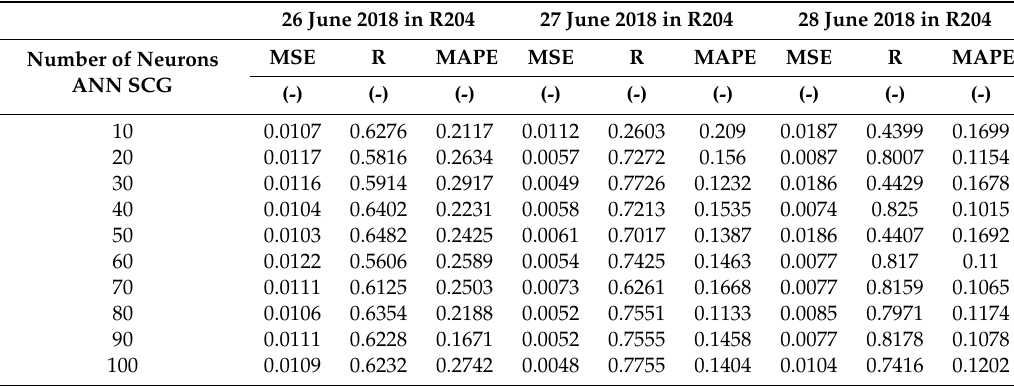
Table 3. Learned ANN SCG from 25 June 2018 in R203 (with T in and rH in ) and prediction with cross-validation for 26 June 2018 in R204 (with T in and rH in ), 27 June 2018 in R204 (with T in and rH in ), and 28 June 2018 in R204 (with T in and rH in ).